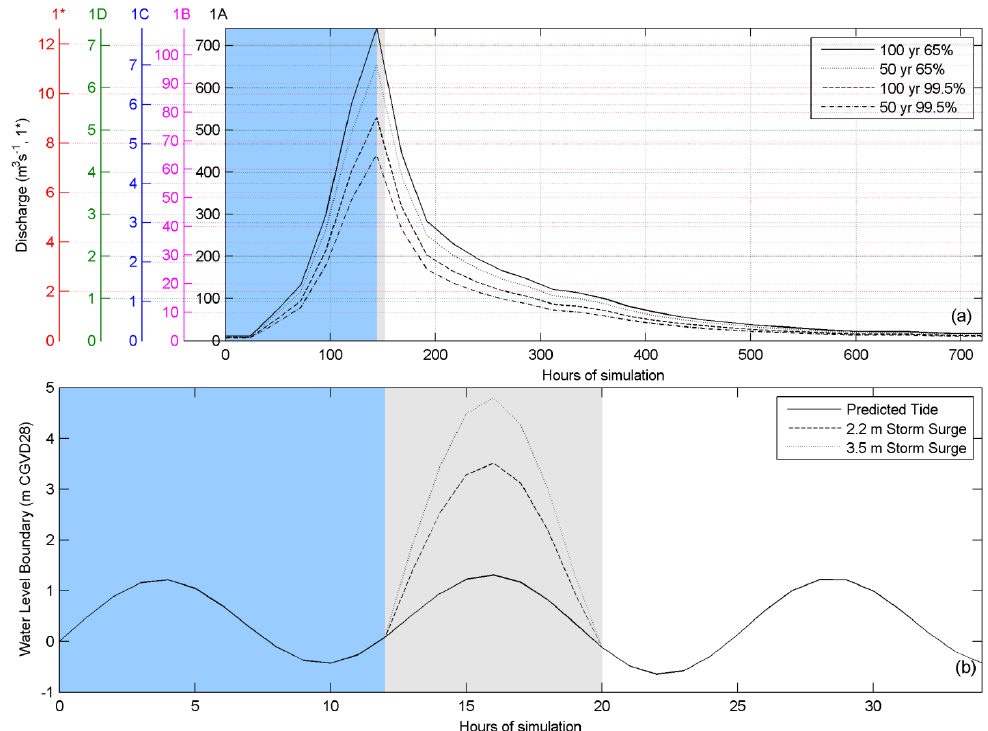
the LaHave River. Colored vertical scales represent how the boundary conditions scale with the drainage area (letters are shown in Figure 4); ( b ) tidal boundary conditions. The blue shading represents the start period and “warm up” of the model and the grey shading represents the time of the simulation and